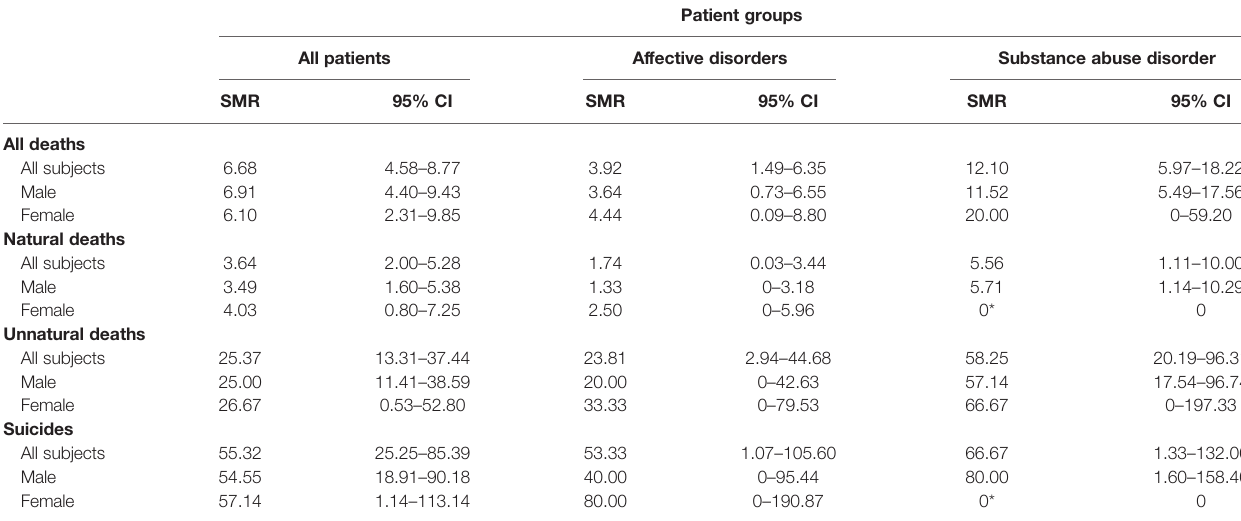
TABLE 5 | Standardized mortality ratios (SMR) and con fi dence intervals (95% CI) of different causes of death in all patients and patients suffering from affective disorders or substance abuse.